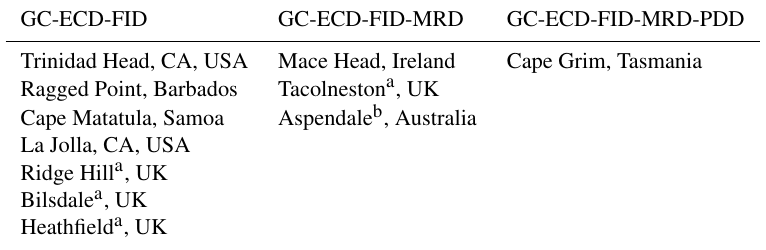
Table 2. GC–multidetector instruments at current AGAGE primary and secondary stations. Detectors: ECD for CFC-11, CFC-12, CFC-113, CH 3 CCl 3 , CCl 4 , N 2 O, and CHCl 3 ; FID for CH 4 ; MRD for CO and H 2 ; and PDD for H 2